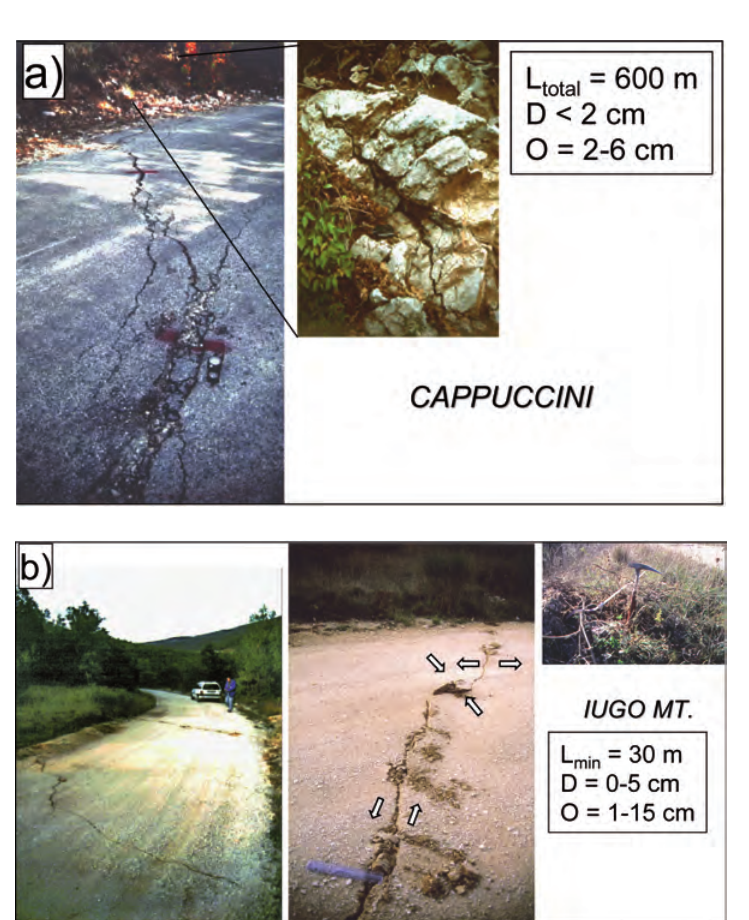
Fig. 9a,b. a) Ruptured paved road at the Cappuccini site, south of the village of Sellano, where a set of N135°- N155° trending fractures extends into bedrock outcrops (see detail to the right) (photo by L. Cucci); b) Fractures break across an unpaved road in the Mt. Iugo area. Extensional and compressional features are observable in the middle photo. The en-echelon pattern of the segments shows a left-lateral component to the motion (arrows il- lustrate the sense of motion; 20 cm long ruler for scale). Deformation in the form of cracks and mole tracks was followed for few tens of meters beyond the road (detail to the upper right; photos by F.R. Cinti and L. Cucci). Photos are taken after the 14 October event. Symbols: L = Length, D = Displacement; O =